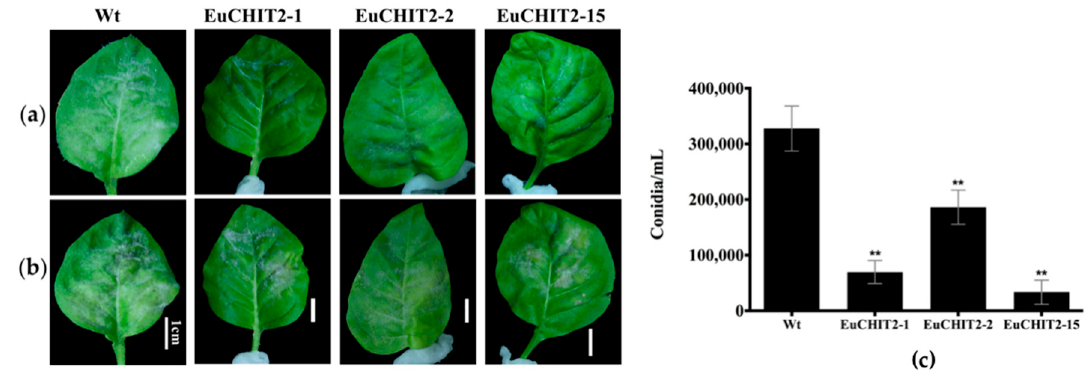
Figure 5. Disease development on N. tabacum cv. Xanthi leaves with E. cichoracearum DC inoculation. ( a ) 7 days after inoculation, and ( b ) 12 days after inoculation. Wt, wild-type, Bars = 1 cm; ( c ) mean number of conidia on leaves of three individual transgenic lines ( n = 9 in each) and the wild-type tobacco plants ( n = 9) 12 days after inoculation with E. cichoracearum DC. Error bars indicate standard deviation, and ** indicates significant differences at p < 0.01, respectively.